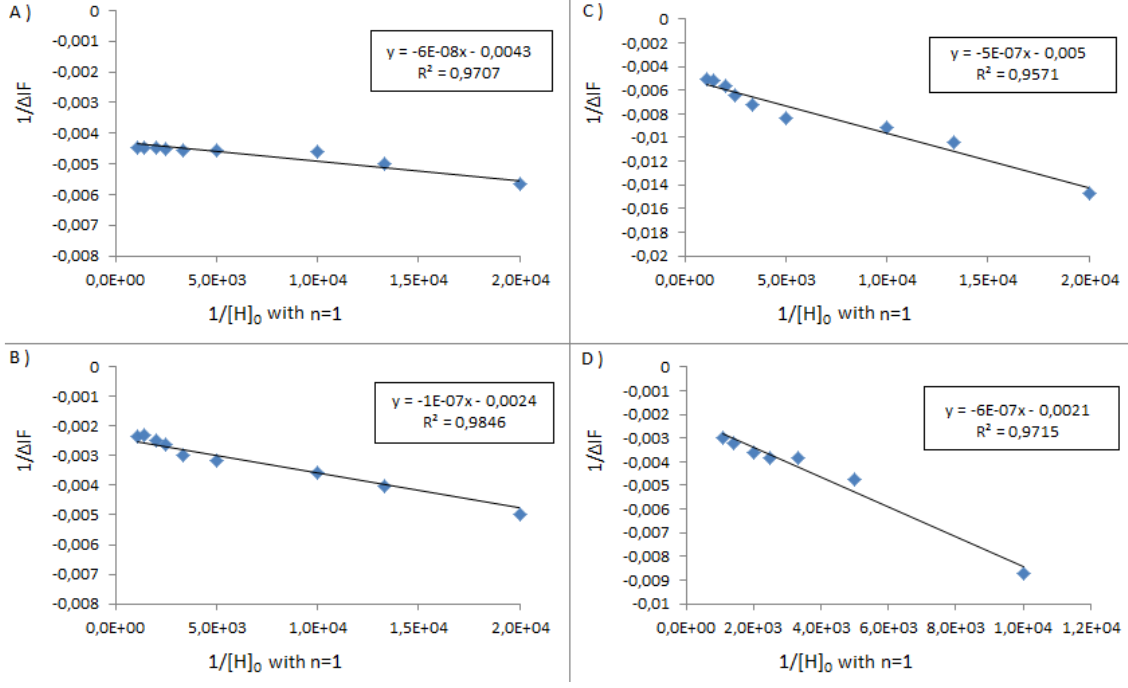
Figure 4. Graph of 1/ Δ If versus 1/[H] for BSA above ( A ) 1 , ( B ) 1 _Ag_NP, ( C ) 2 , 0 ( D ) 2 _Ag_NP. In the inset, the straight line equation with the coefficient of determination R 2 .